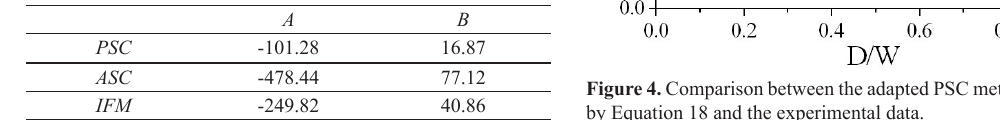
Table 4. PSC, ASC and IFM constants obtained for Equation 18.